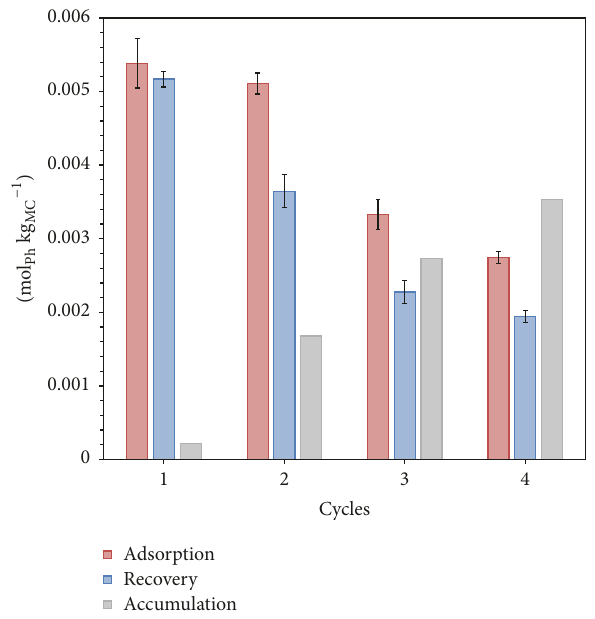
Figure 6: Reusability studies of CA-MC-Cy for phenol extraction. Experimental conditions for the extraction step: 50 mL of phenol at 25 mg L −1 (pH = 3 ), 2 g of CA-MC-Cy prepared with 1mol L −1 of extractant reagent. Experimental conditions for the recovery step: 2 g of CA-MC-Cy-Ph and 50 mL of NaOH 0.25 mol L −1 , 24 h of contact